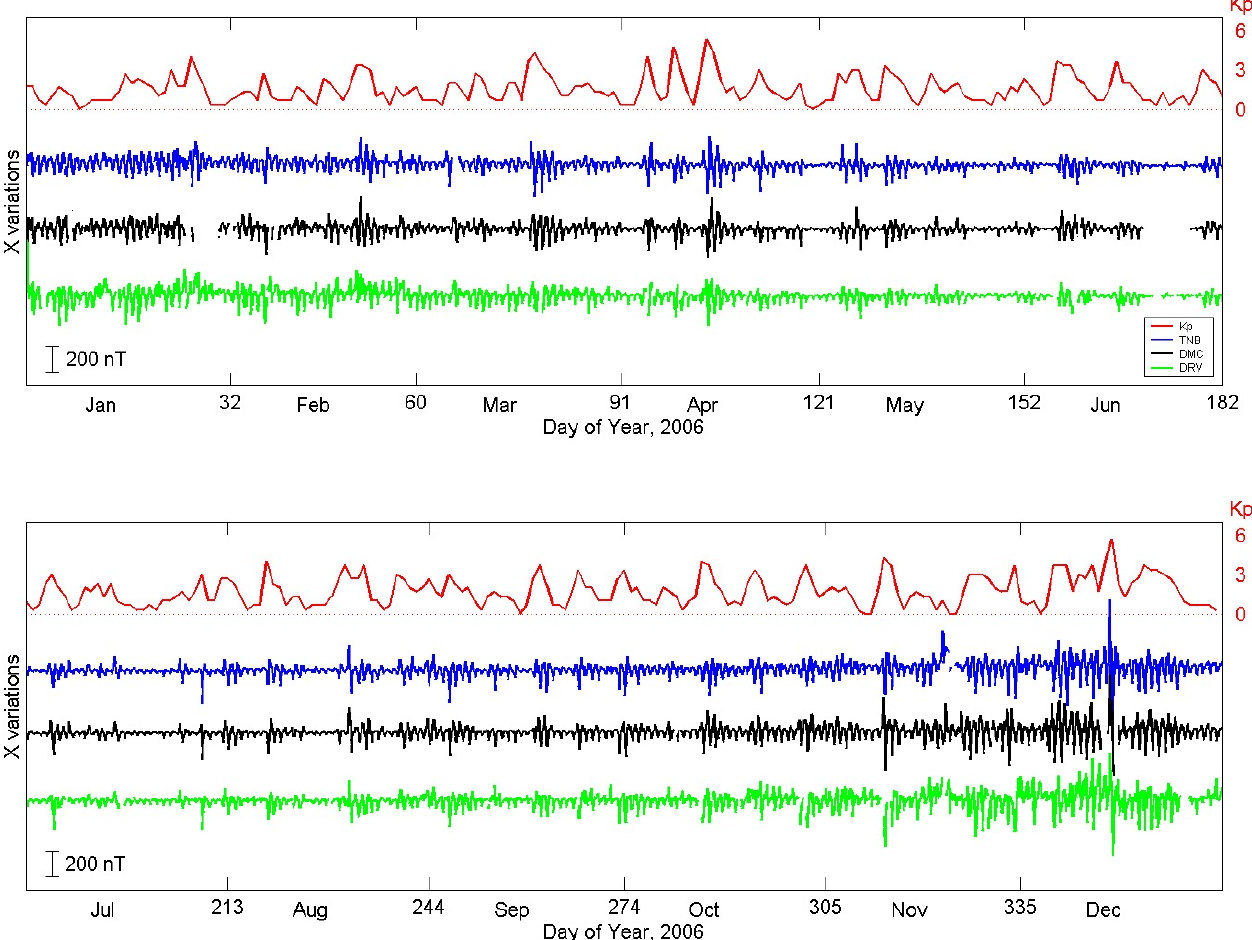
Fig. 2. Hourly values of the variations of the X component during 2006 for the three observatories, with the daily averages of the K p index.